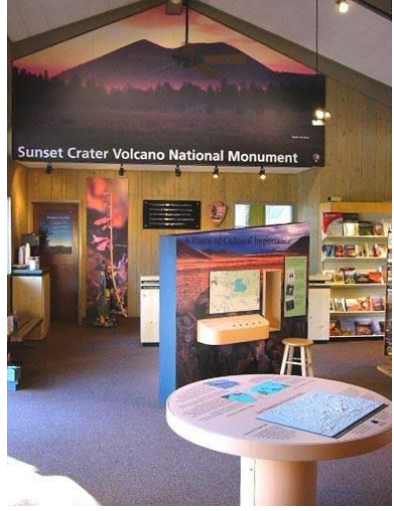
Figure 12. Kiosk in Center with Map of Reservations and Phone for Talking with an Elder from Any of the Nine Tribes.